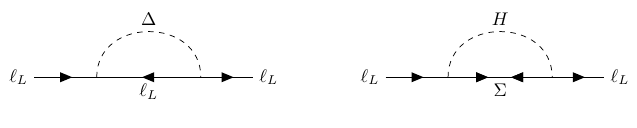
in the type-II and -III models ˜ X‘